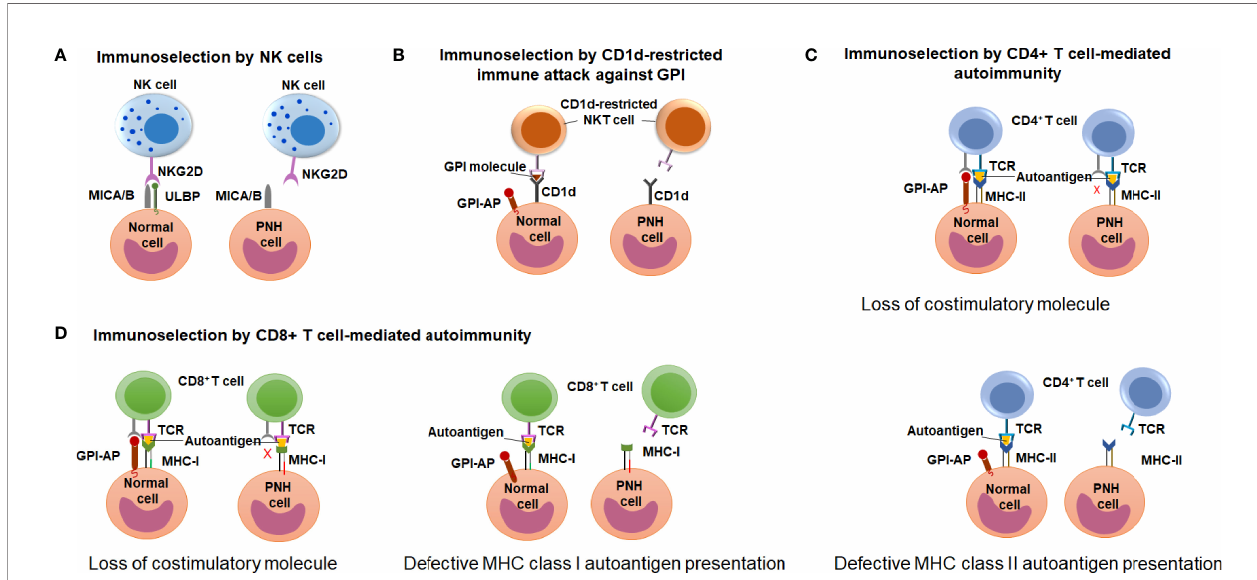
FIGURE 6 | Potential mechanisms of immune-escape by the PNH cells. (A) A schematic diagram illustrating the hypothesis of immunoselection of GPI (-) cells by NK cells. Normal GPI (+) cells express NKG2D ligands ULBPs and MICA/B, and activate NK cells (left), whereas the lack of ULBPs on GPI (-) PNH cells leads to an impaired NK activation (right). (B) A schematic diagram illustrating the immunoselection of GPI (-) cells by CD1d-restricted immune attack against GPI. CD1d- restricted, GPI-speci fi c NKT cells target GPI molecule presented by CD1d and attack GPI (+) normal HSPCs (left) but not the GPI (-) PNH HSPC (right). (C) A schematic diagram illustrating the hypothesis of immune selection of GPI (-) cells by CD4 + lymphocyte-mediated attack. GPI (-) cell may have the reduced ability to activate autoreactive CD4 + T lymphocytes due to missing GPI-anchored co-stimulatory molecules (top diagram). Alternatively, GPI (-) PNH cells may have reduced MHC class II presentation of hypothetical autoantigens compared to GPI (+) normal cells, and survive CD4 + T cell mediated immune attack due to their reduced recognition (bottom diagram). (D) A schematic diagram illustrating the hypothesis of immune selection of GPI (-) cells by CD8 + lymphocyte-mediated attack. GPI (-) cell may have the reduced ability to activate autoreactive CD4 + T lymphocytes due to missing GPI-anchored co-stimulatory molecules (left diagram). Alternatively, GPI (-) PNH cells may have reduced MHC class I presentation of hypothetical autoantigens compared to GPI (+) normal cells, and survive CD8 + T cell mediated immune attack due to their reduced recognition (right